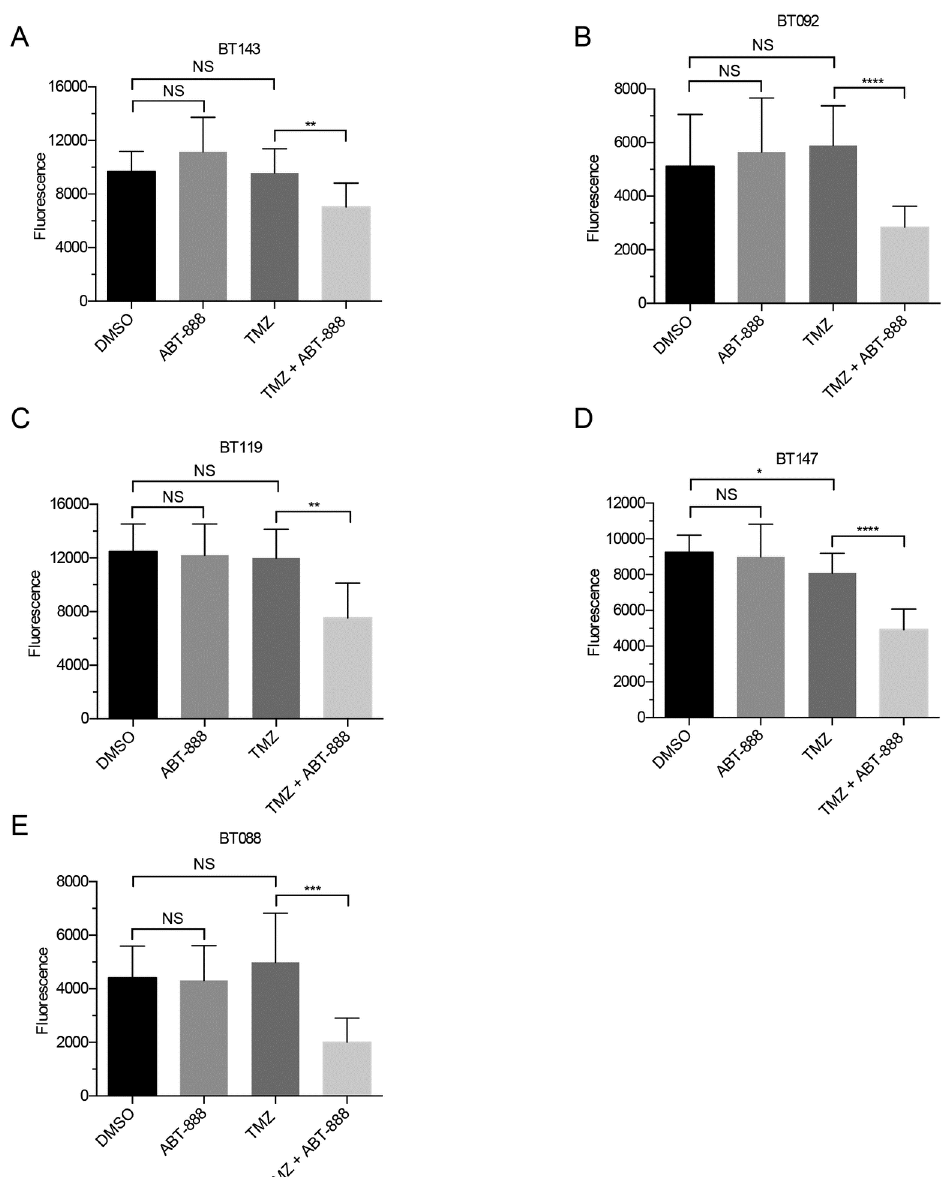
Fig 3. Average viability of Group III BTICs (n = 3, ± SD). Assessments and statistics were performed as in Fig 1. Viability was unaffected by ABT-888 alone and by TMZ alone, except for BT147 (D). The combination decreased viability in all BTIC lines (ns = p > 0.05; (cid:3) = p < 0.05; (cid:3)(cid:3) = p < 0.01; (cid:3)(cid:3)(cid:3) = p < 0.001; (cid:3)(cid:3)(cid:3)(cid:3) = p <